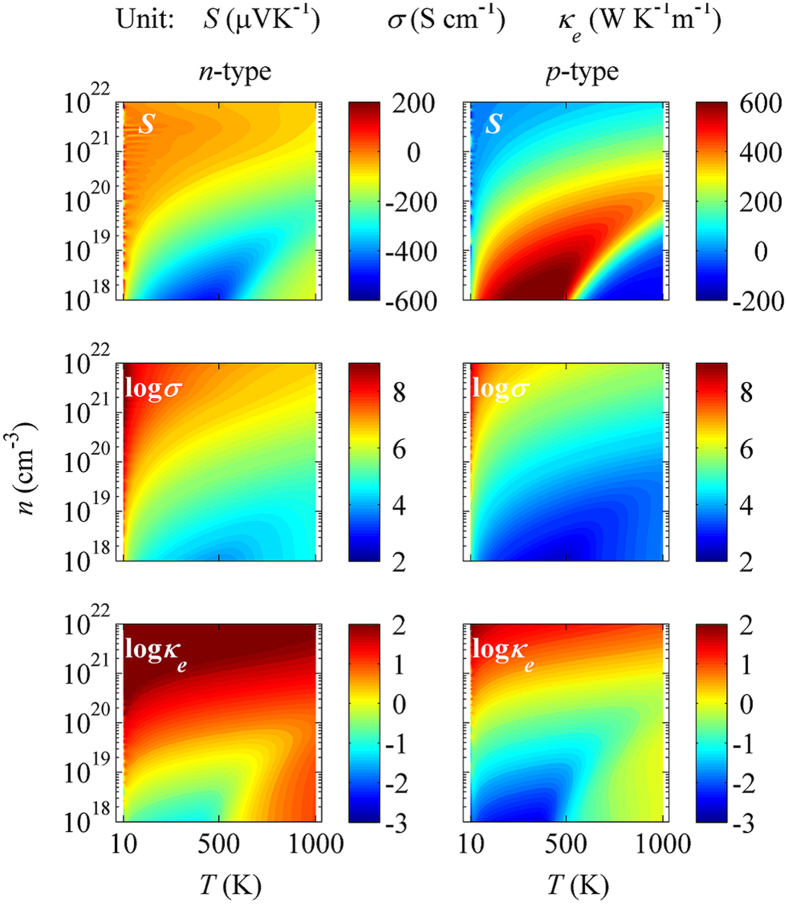
The calculated S (top row), logσ (middle row), and logκe (bottom row) on the (T, n) plane for carrier-doped NbFeSb.Left panel: n-type and right panel: p-type.